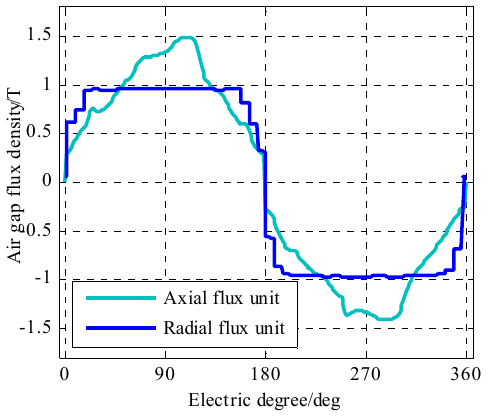
Figure 11. Flux density distribution.